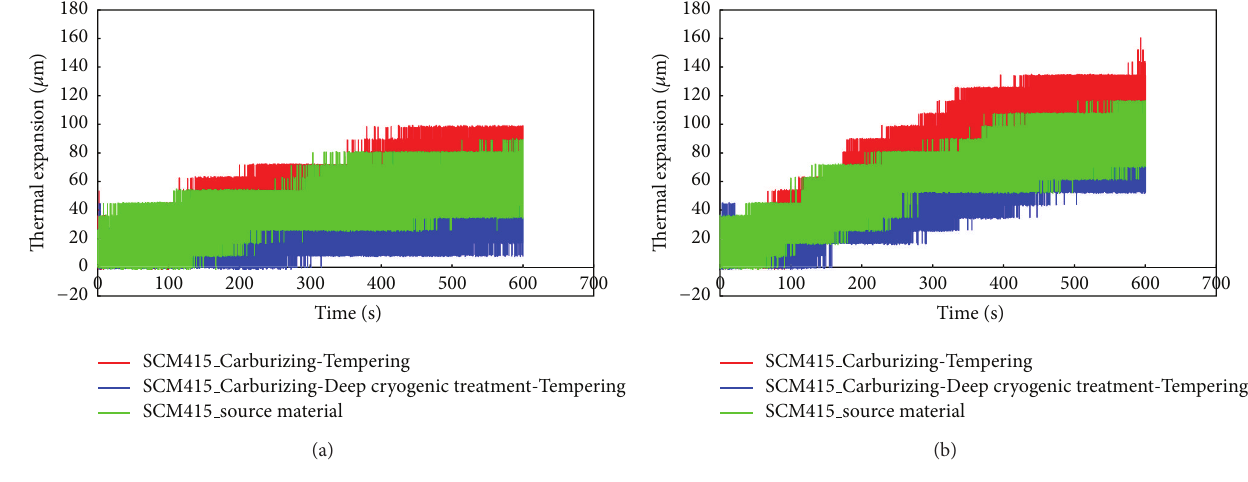
Figure 8: Dynamic responses of microthermal expansion for the specimen under different composite heat treatments: (a) the heating temperature of 100 ∘ C and (b) the heating temperature of 150 ∘ C.